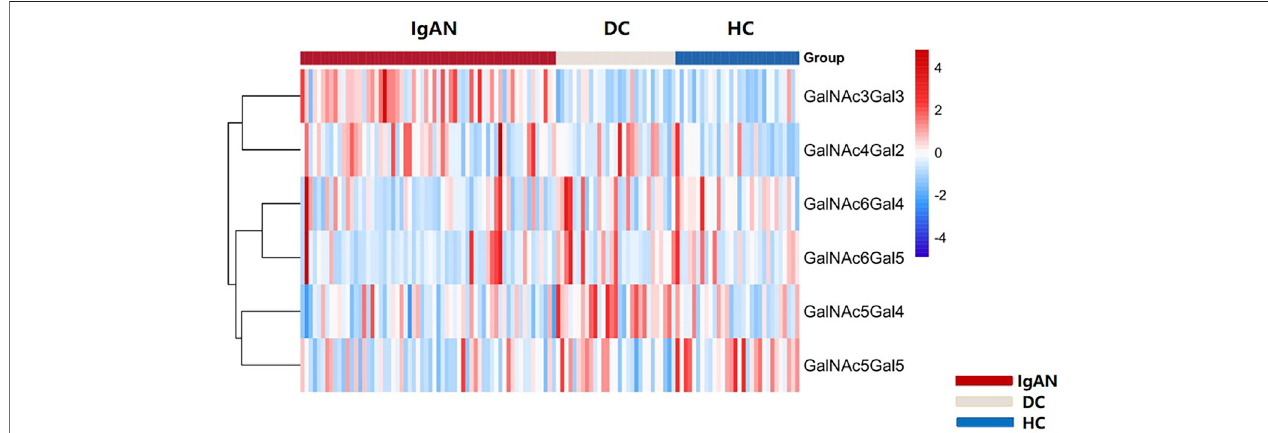
FIGURE 4 | Heatmap of six differential glycoforms in IgA1 HR among IgAN, DC and HC group. The bar represented Z-score changed from-4 to 4. Similarly, the color of the bar from red to blue represented the fold change from increasing to decreasing of O-glycoforms in IgA1